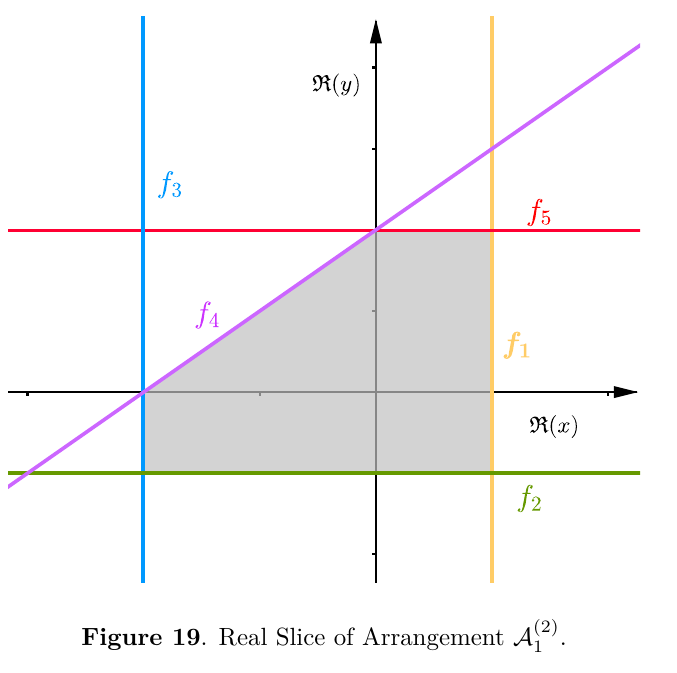
Figure 19 . Real Slice of Arrangement A (2)